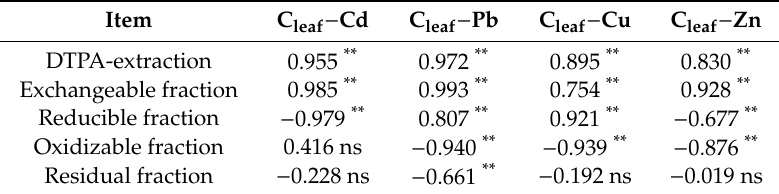
Table 2. Pearson correlation coe ffi cients were used to analyze the relationship between the di ff erent metal fractions in the soil and the metal content in the plant materials. Item C leaf − Cd C leaf − Pb C leaf − Cu C leaf − Zn DTPA-extraction 0.955 ** 0.972 ** 0.895 ** 0.830 ** Exchangeable fraction 0.985 ** 0.993 ** 0.754 ** Reducible fraction − 0.979 ** − 0.019 ns F-values for the available fractions of metals were determined by the accumulation and interaction of metals in tobacco; ns, nonsignificant F ratio ( p ≤ 0.05); ** indicates that the correlation is significant at the 0.01 level and indicates a negative